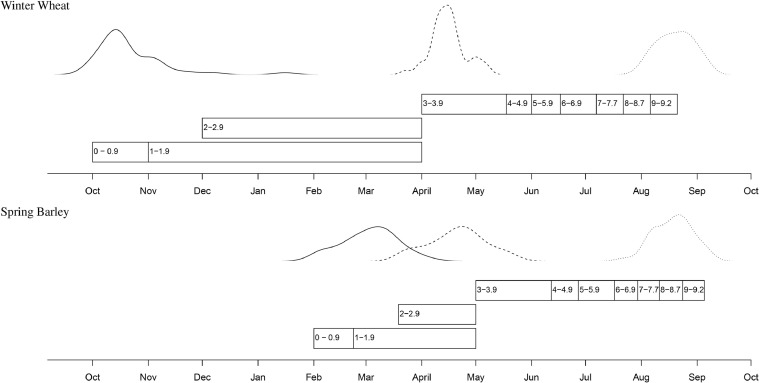
Distribution of sowing (solid line), nitrogen application (kg N ha−1; dashed line) and harvest dates (dotted line) for Broadbalk wheat and Hoosfield spring barley. Data includes harvest seasons 1968 to 2016 (2013 and 2015 were excluded from Broadbalk due to late sowing). Also included are the decimal phenological growth stage scores for both cereals (Tottman et al., 1979; Zadock et al., 1974) summarised in Gooding and Davis (1997).